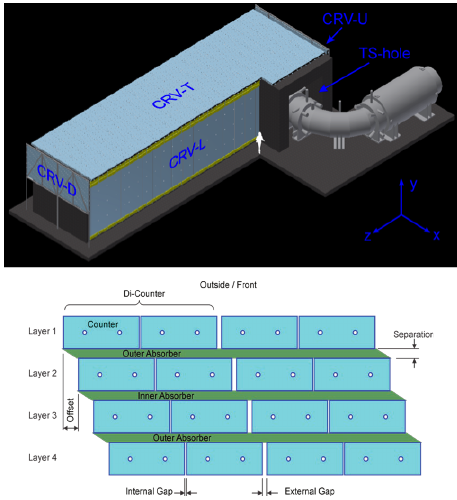
Figure 11. (Top) drawing of the CRV coverage of DS and DS-TS entrance. (Bottom) layout of a CRV module.